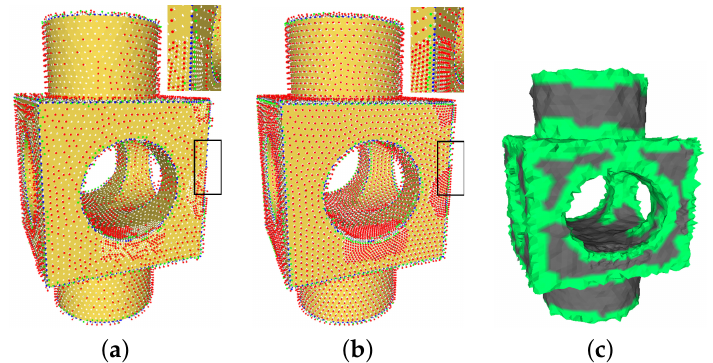
Figure 7. Correcting the direction of the feature vector: ( a ) original eigenvectors; ( b ) corrected eigenvectors; and ( c ) clustering results (green) after denoising the non-feature